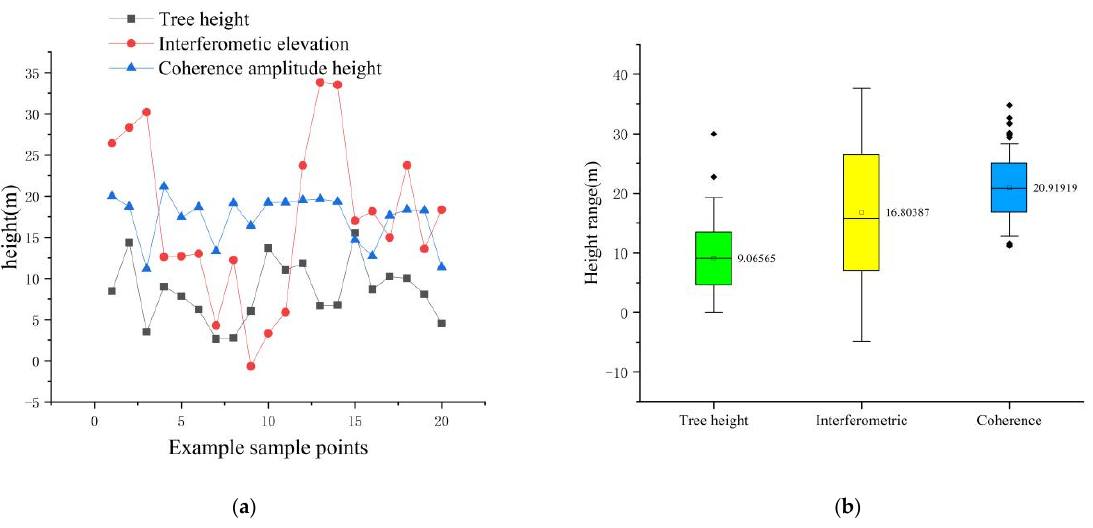
Figure 8. comparison line plots ( a ) and box plots ( b ). Figure 8. Comparison line plots ( a ) and box plots ( b ).